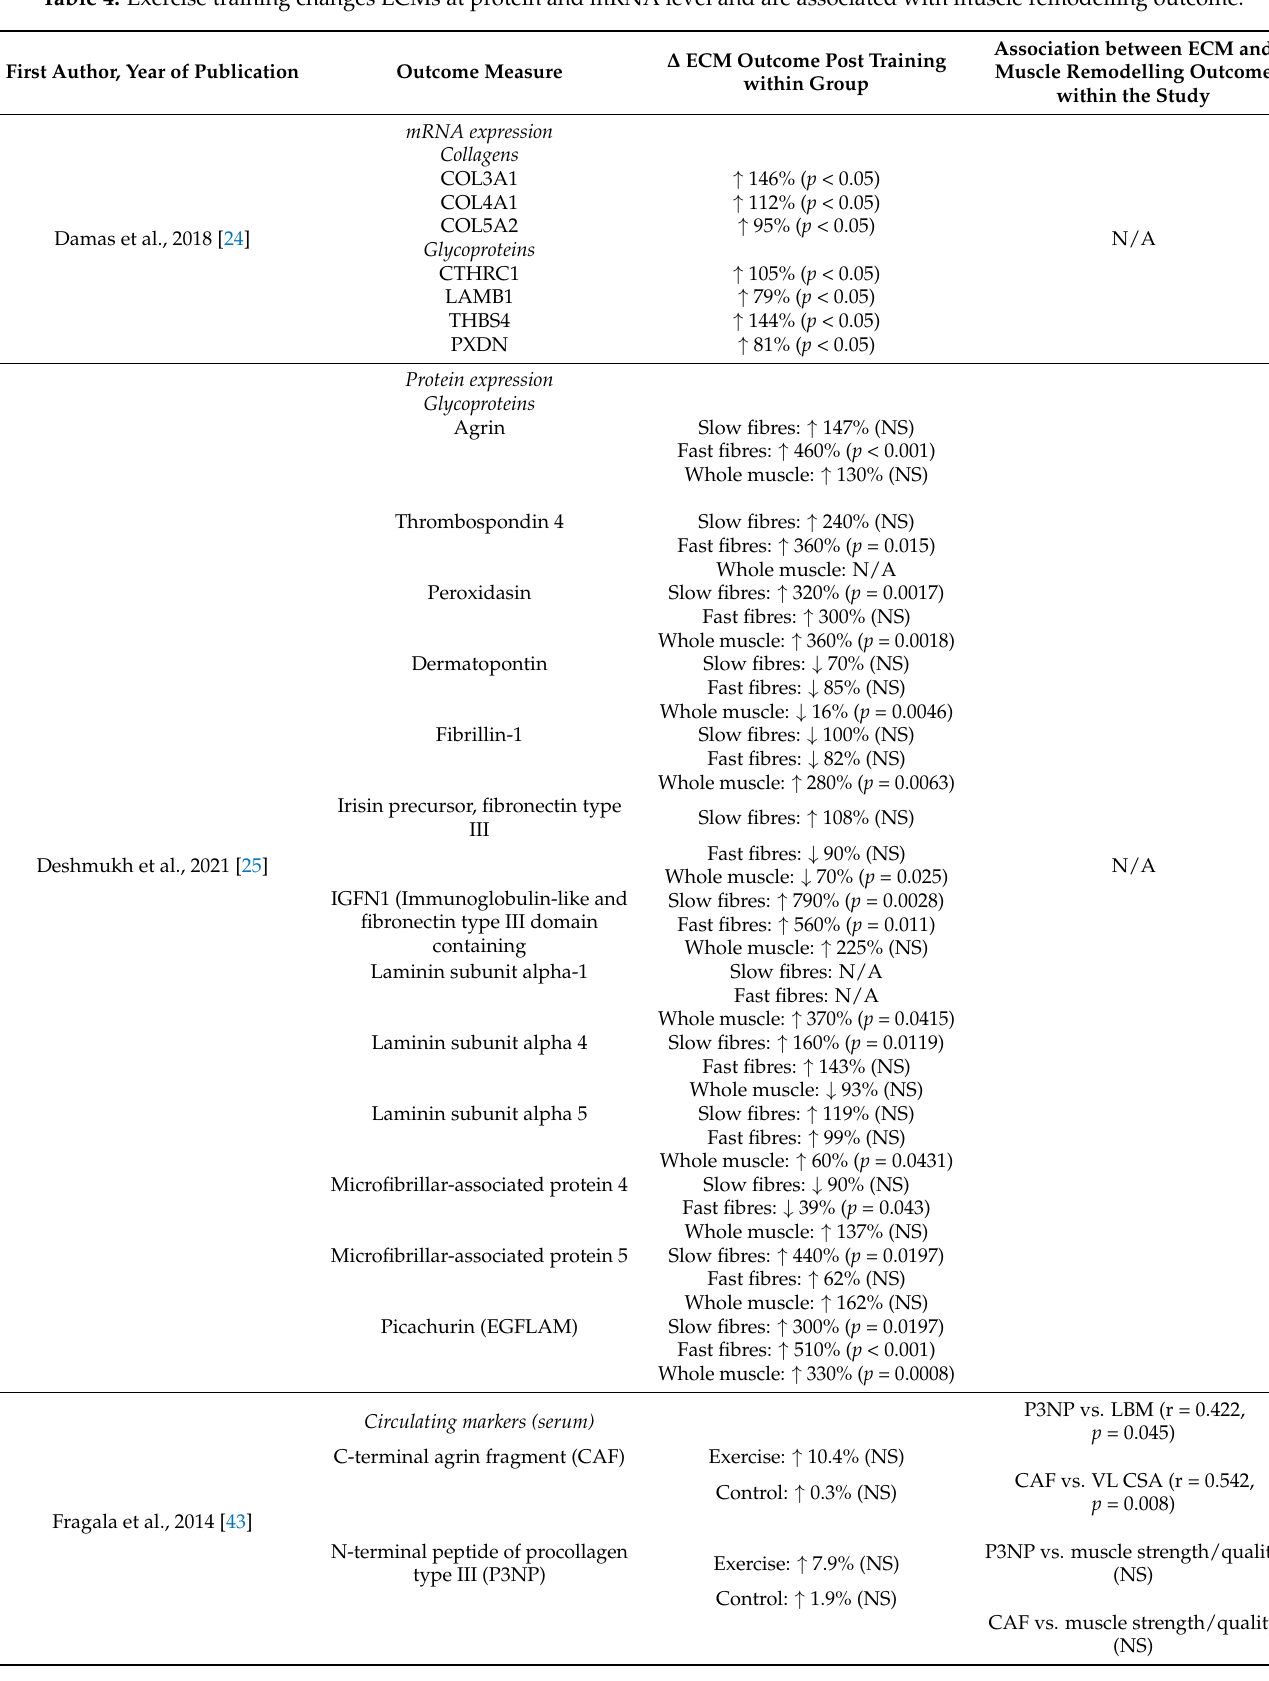
Table 4. Exercise training changes ECMs at protein and mRNA level and are associated with muscle remodelling